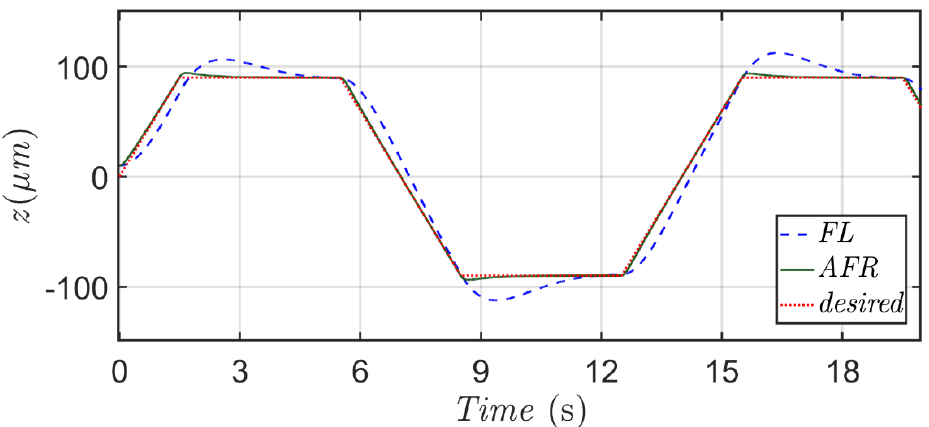
Figure 4. Micro-positioning results of output displacement z based on the proposed method (green line) and feedback linearization method (blue dash line) with respect to a desired trapezoid trajectory (red dotted line).